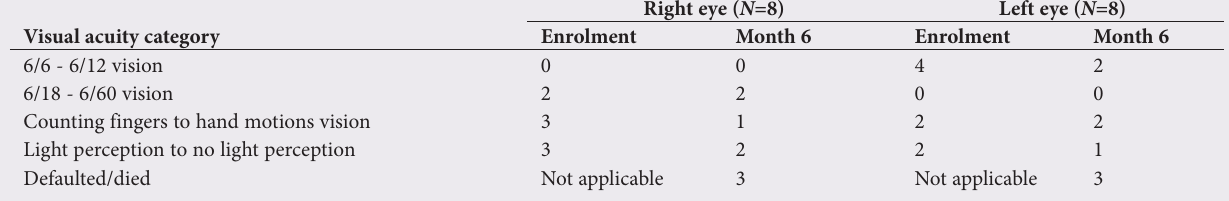
Table 2. Visual acuity at enrolment and month